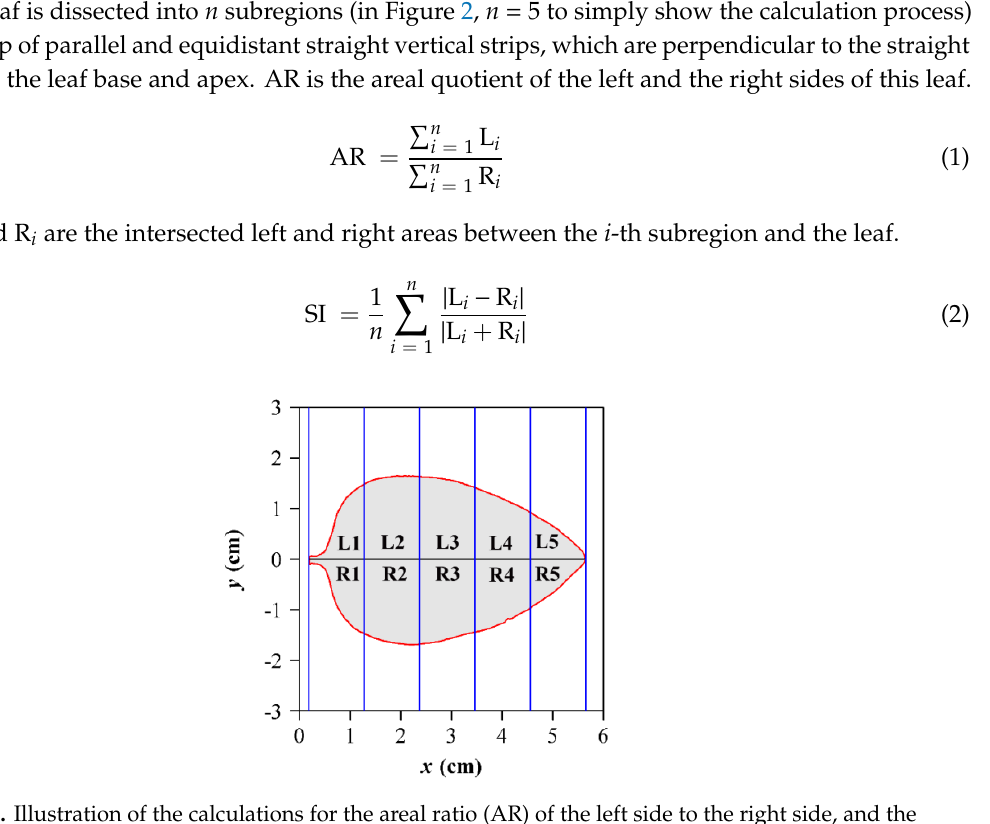
Figure 2. Illustration of the calculations for the areal ratio (AR) of the left side to the right side, and the standardized index (SI) for measuring leaf bilateral symmetry. L1 to L5 represent the areas of the upper (left) subregions (i.e., the intersections between strips that were formed by the adjacent blue vertical lines with the left side of this leaf), and R1 to R5 represent the areas of the lower (right) subregions. AR = (L1 + L2 + L3 + L4 + L5) / (R1 + R2 + R3 + R4 + R5), and SI = [ | L1 − R1 | / (L1 + R1) + | L2 − R2 | / (L2 + R2) + | L3 − R3 | / (L3 + R3) + | L4 − R4 | / (L4 + R4) + | L5 − R5 | / (L5 + R5)] / 5. In this figure, we only used 5 strips (that were formed by two adjacent blue vertical lines) for conveniently showing the calculation process, and during the actual calculations we used 1000 strips within a given leaf using the computer codes developed by Shi et al. [20] and Su et al. [32]. SI is actually the average of the relative areal di ff erences of the n subregions (see Figure 2